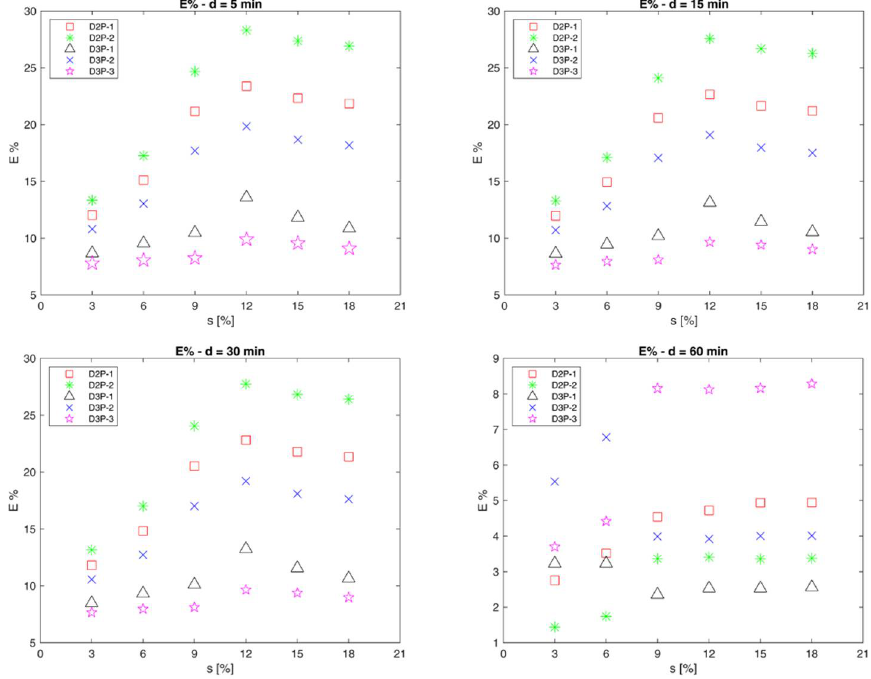
Figure 11. E% on Peak discharge for short durations.